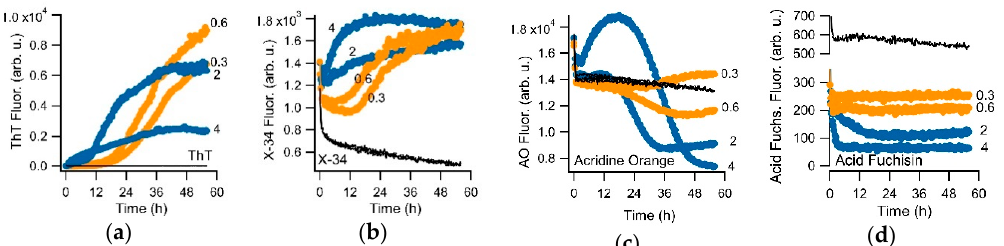
Figure 4. Fluorescence kinetics during sigmoidal and biphasic hewL amyloid assembly for various fluorescent dyes. Kinetics responses of ( a ) thioflavin T, ( b ) the amyloid dye X-34 ( λ ex = 370 nm, λ em = 482 nm), ( c ) acridine orange ( λ ex = 495 nm, λ em = 532 nm), and ( d ) acid fuchsin ( λ ex = 560 nm, λ em = 590